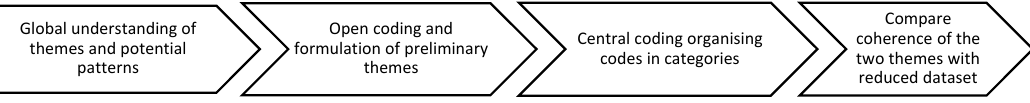
Figure 2. Thematic analysis process.